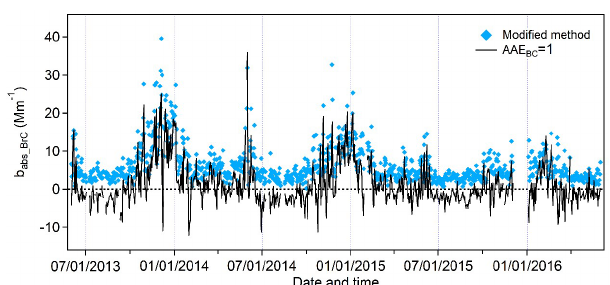
Figure 4. Comparison between the time series of daily mean b abs_BrC using the modified method and using AAE BC = 1 . 0. The blue diamonds represent the calculation result using R AAE = 0 . 65, which is the mean value from SP2 data. Calculated b abs_BrC using AAE BC = 1 . 0 is plotted by the black